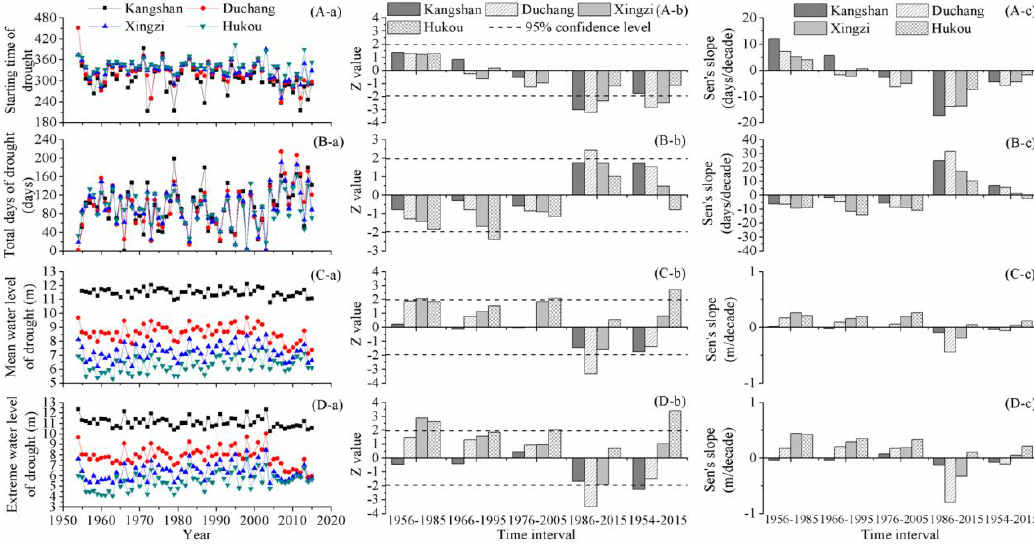
Figure 6. Change characteristics of drought in Poyang Lake: (i) the sub-figures labeled (A–D) display change features of starting time of droughts, total days of drought, mean water level of droughts, and extreme water level of droughts, respectively; and (ii) the sub-figures labeled (a–c) display annual values, Z values, and Sen’s slopes, respectively.